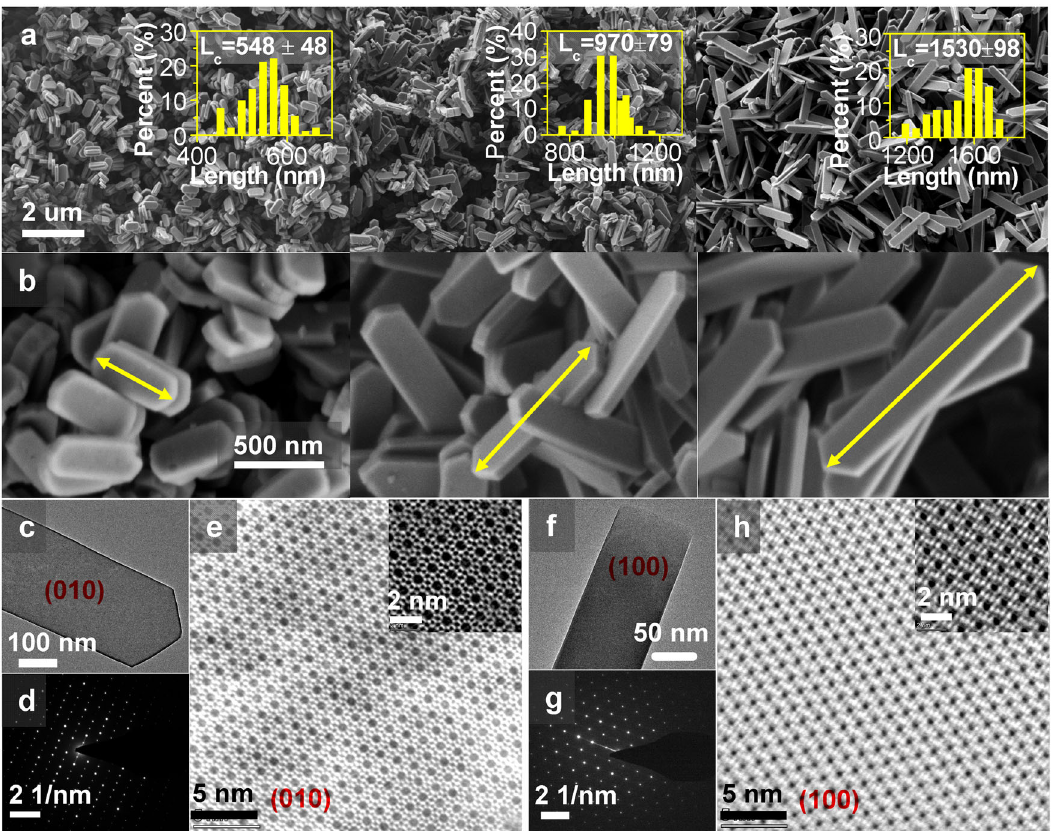
Fig. 2 The morphology of the as-synthesized H-ZSM-5 samples. a , b SEM results of H-ZSM-5 zeolites with similar thicknesses of a - and b -axis but different lengths of c -axis. Left: Z-cS; middle: Z-cM; right: Z-cL. c TEM image of Z-cL sample with exposed facets of [010] plane. d The corresponding SAED patterns of [010] plane. e Aberration-corrected STEM image of Z-cL sample with exposed facets of [010] plane, with the inset on the top right displaying the STEM image with high resolution and the framework structure of H-ZSM-5 projected along [010] plane. f – h TEM image, the corresponding SAED patterns, and the aberration-corrected STEM image of Z-cL sample with exposed facets of [100] plane.